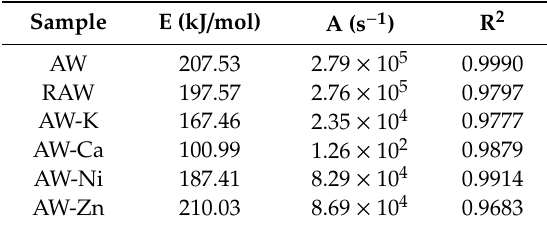
Figure 5. Arrhenius plot of char samples using RPM model. Table 3. The kinetic parameters of all char samples.